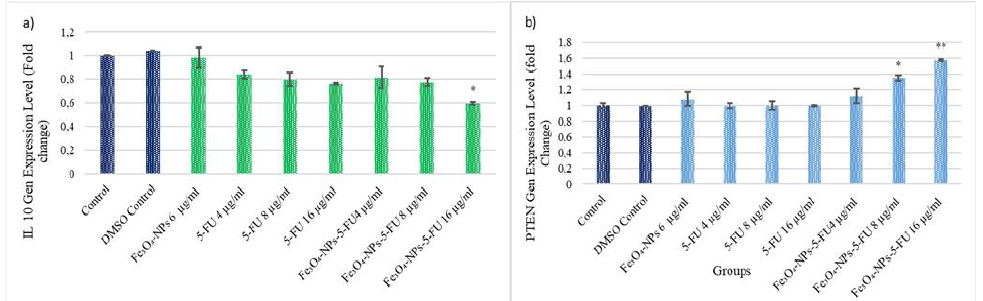
Figure 7. The effect of Fe 3 O 4 0-NPs, 5-FU, and Fe 3 O 4 _NPs + 5-FU on PTEN and IL-10 gene expression. ( a ) IL-10 gene level; ( b ) PTEN gene level (n = 3). Cells were cultured in 96-well plates and treated with Fe 3 O 4 _NPs 6 µ g/mL, 5-FU (4, 8, and 16 µ g/mL), and combinations of Fe 3 O 4 + 5-FU NPs for 72 h. The results represent the average of three separate experiments. Statistical significance: * p < 0.05; ** p < 0.01.